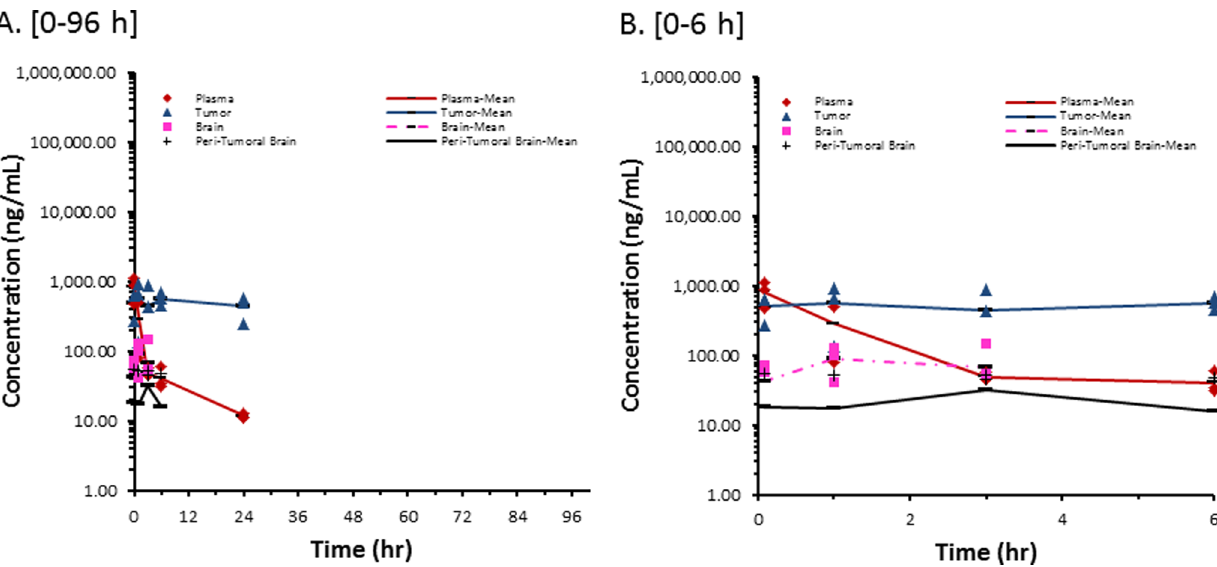
Figure 1. Sum Total Doxorubicin Concentrations from NonL-doxo. Individual and mean sum total doxorubicin concentration in plasma, brain tumor, contralateral non-tumor brain, and peri-tumoral brain of female athymic nude (nu/nu) mice bearing intracranial MDA-MB-231-BR human triple-negative breast cancer xenografts following administration of nonliposomal doxorubicin (NonL-doxo) at 6 mg/kg IV 6 1. Samples (n=3 mice at each time point) were obtained at 0.083, 1, 3, 6, 24, 72 and 96 hours following administration of NonL-doxo. Concentrations were undetectable after 3 hours (contralateral non-tumor brain), 6 hours (peri-tumoral brain), and 24 hours (plasma and tumor) of administration. ( A ) 0–96 h; ( B ) 0–6 h.